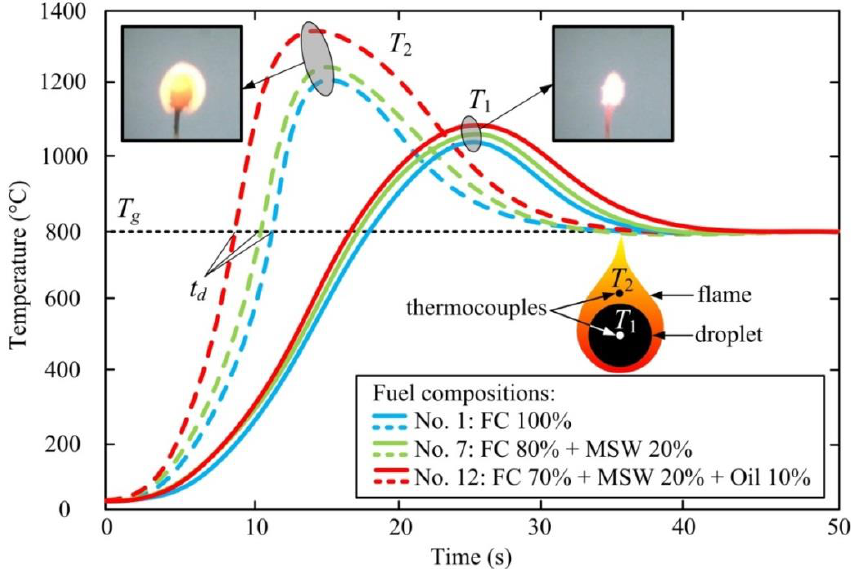
Figure 4. Temperature change of composite liquid fuel droplets of different compositions with initial diameter of 2 mm during the induction period at T g = 800 °C.